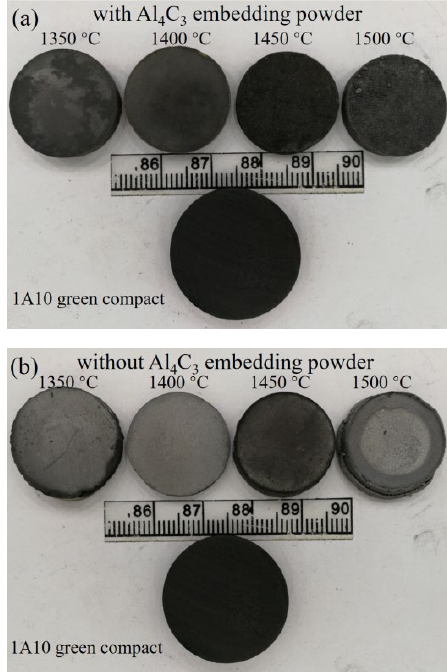
Fig. 5 Dependence of zeta potential on the pH value in the suspensions of Ti 3 AlC 2 powder with arabic gum or PAA as dispersant.